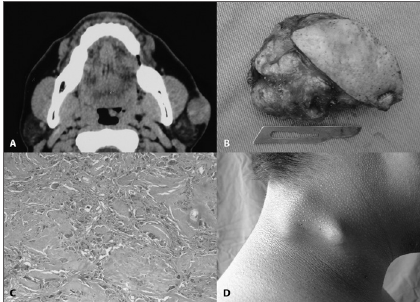
Figure 1. A: CT scan axial view of a face showing a nodular gro- wth of about 4cm in its longest axis, subcutaneously located